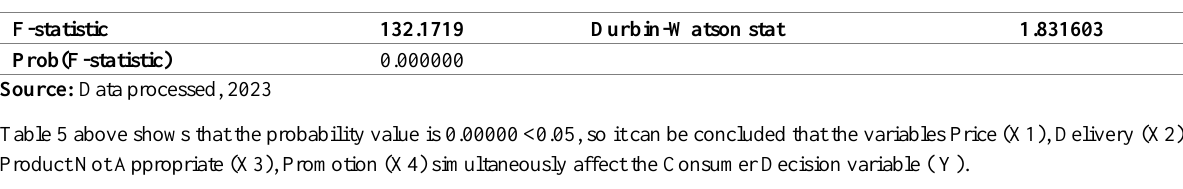
Table 5: Simultaneous Regression Coefficient Test Results (Test F)